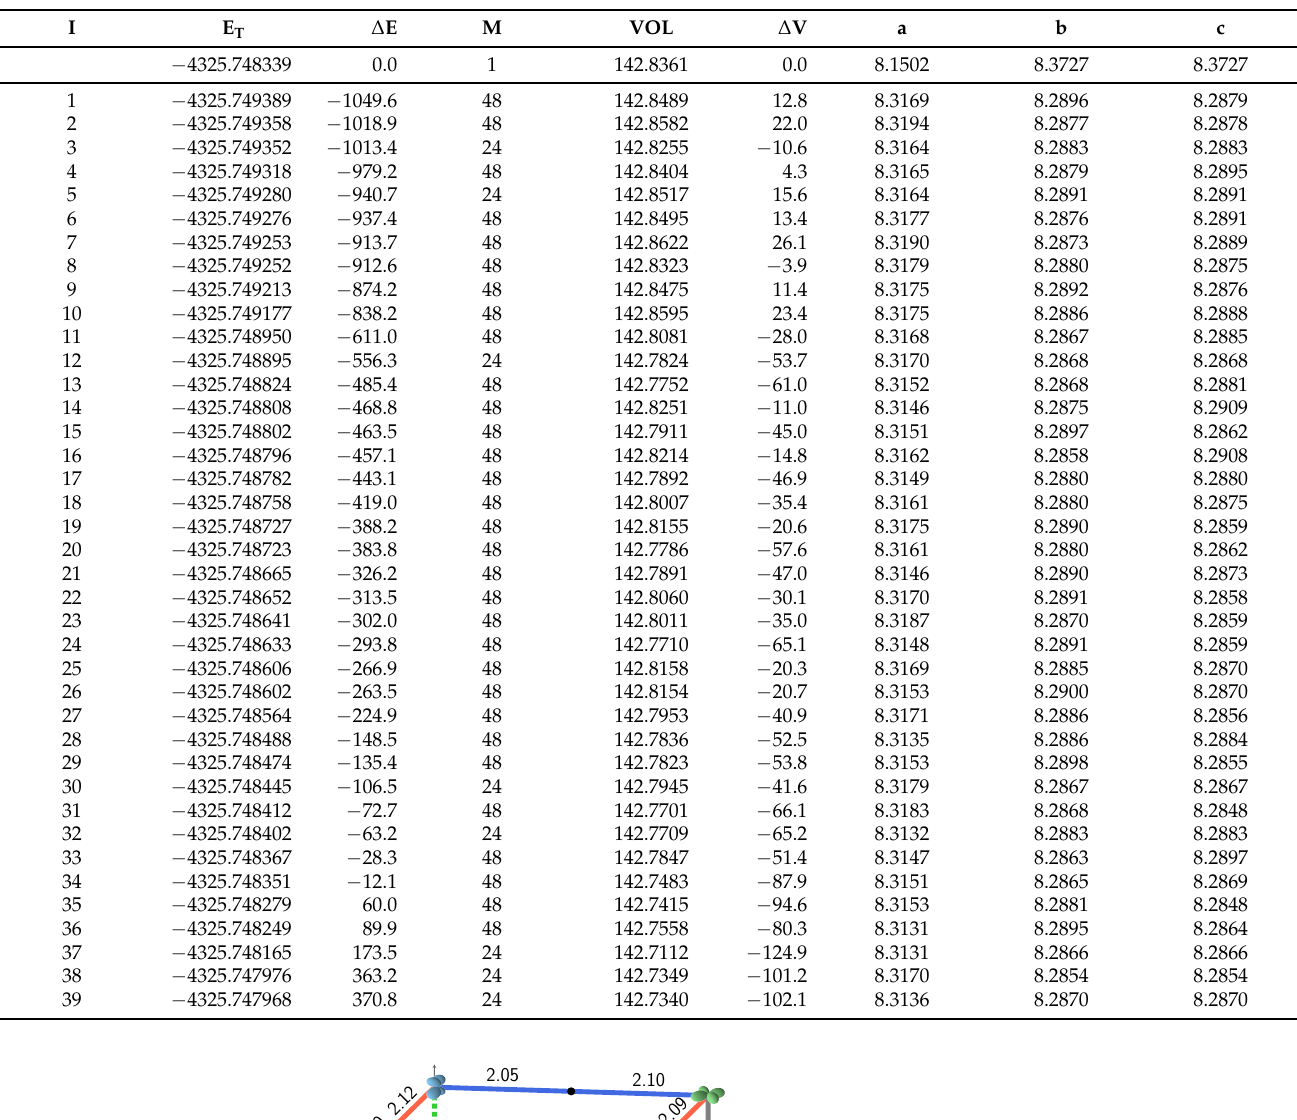
Table A6. Total energy E T (in E h ) and volume V (in Å 3 ) for the 39 SICs of the (2,3,3) CEC of the 2 × 2 × 2 supercell (S222) at PBE0 level for the FM solution and for 2 formula units of KFeF 3 . The SIC multiplicity is given by the M column. ∆ E (in µ E h ) and ∆ V (in mÅ 3 ) are the energy and volume differences (or relative energy or volume) with respect to the REF case. In the last three columns the lattice parameters of the S222 supercell (40 atoms) are shown.